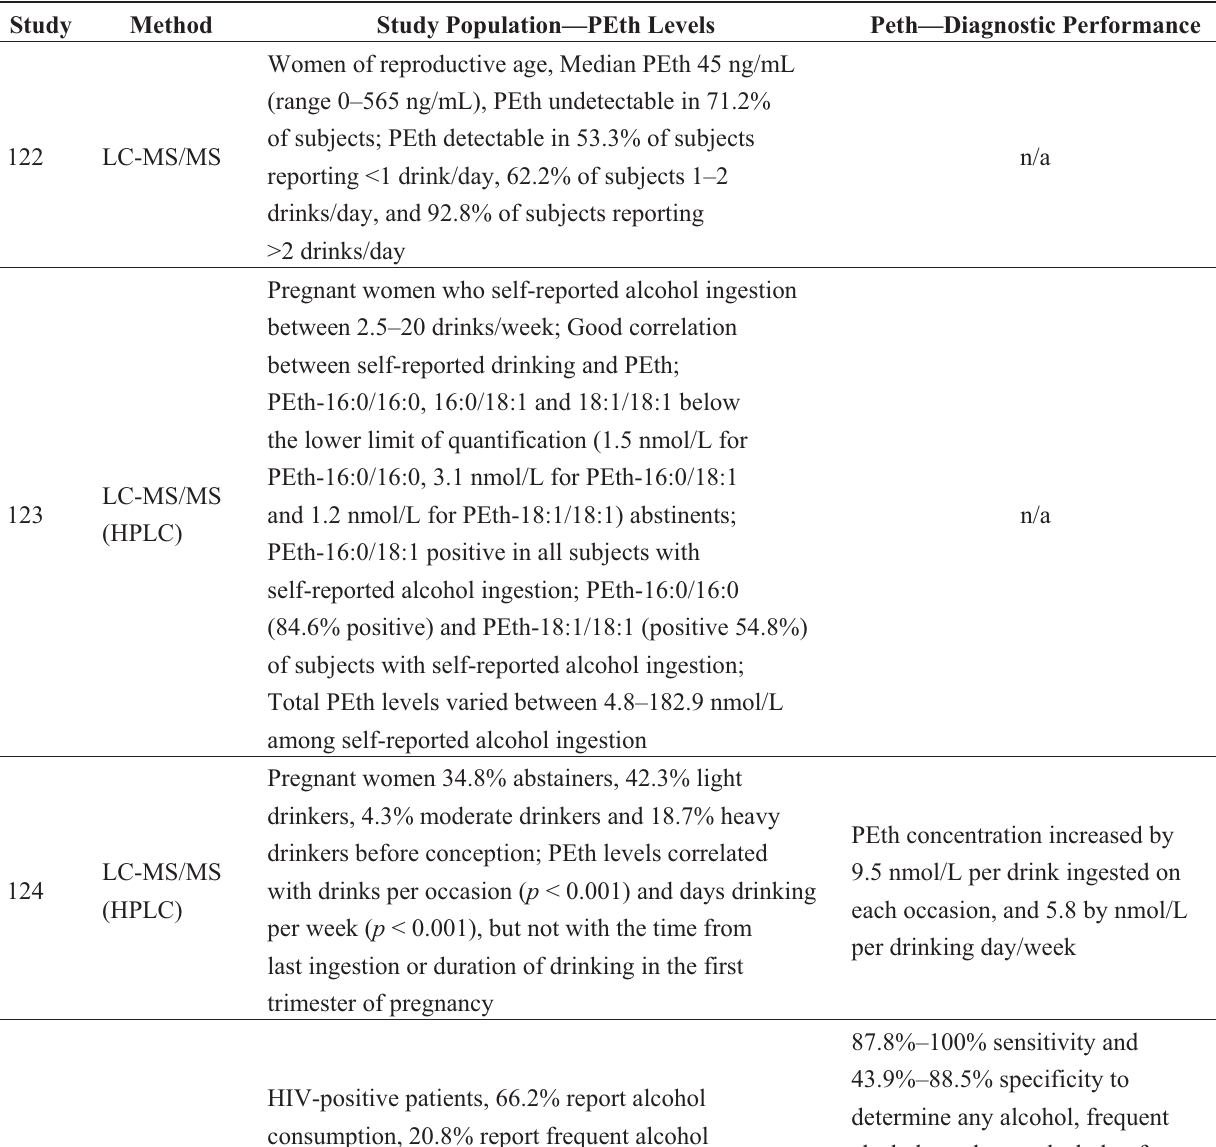
Table 2. Phosphatidylethanol in